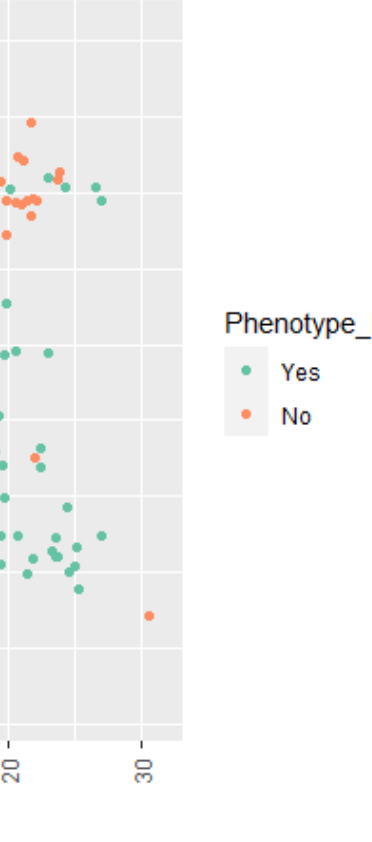
Figure 1. Plot of DC2+_Dry breeding values and DC2+_Wet breeding values.